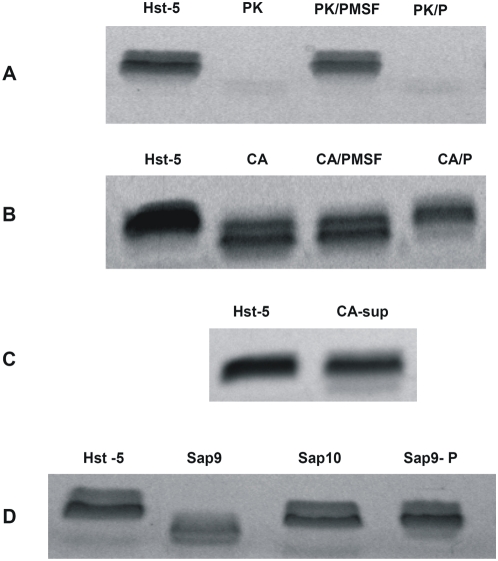
Degradation of Hst-5 under various conditions and C. albicans strains.(A) Complete degradation of Hst-5 by proteinase K (PK) used as positive control and inhibition of degradation by PMSF but not by pepstatin A (P) (B) Conversely, inhibition of C. albicans degradation by pepstatin A but not by PMSF (C) Minimal degradation observed when Hst-5 was incubated with C. albicans supernatant (CA-sup) D) Significant degradation of Hst-5 by 0.0625 µg Sap9 and Sap10 purified proteases and inhibition of degradation by pepstatin A.